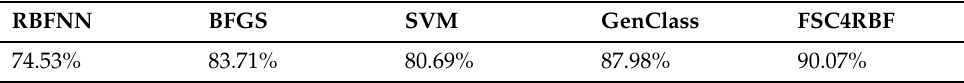
Table 2. Results